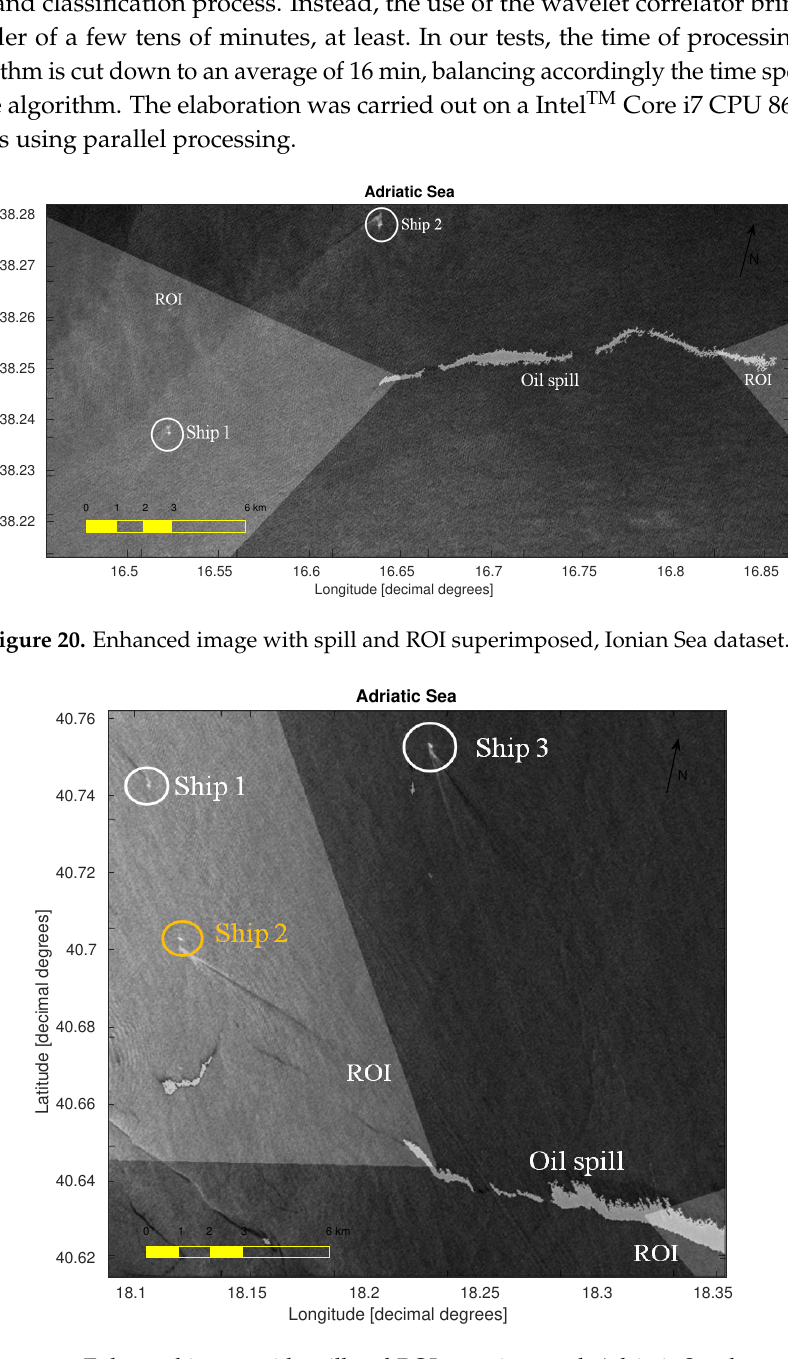
Figure 21. Enhanced image with spill and ROI superimposed, Adriatic Sea